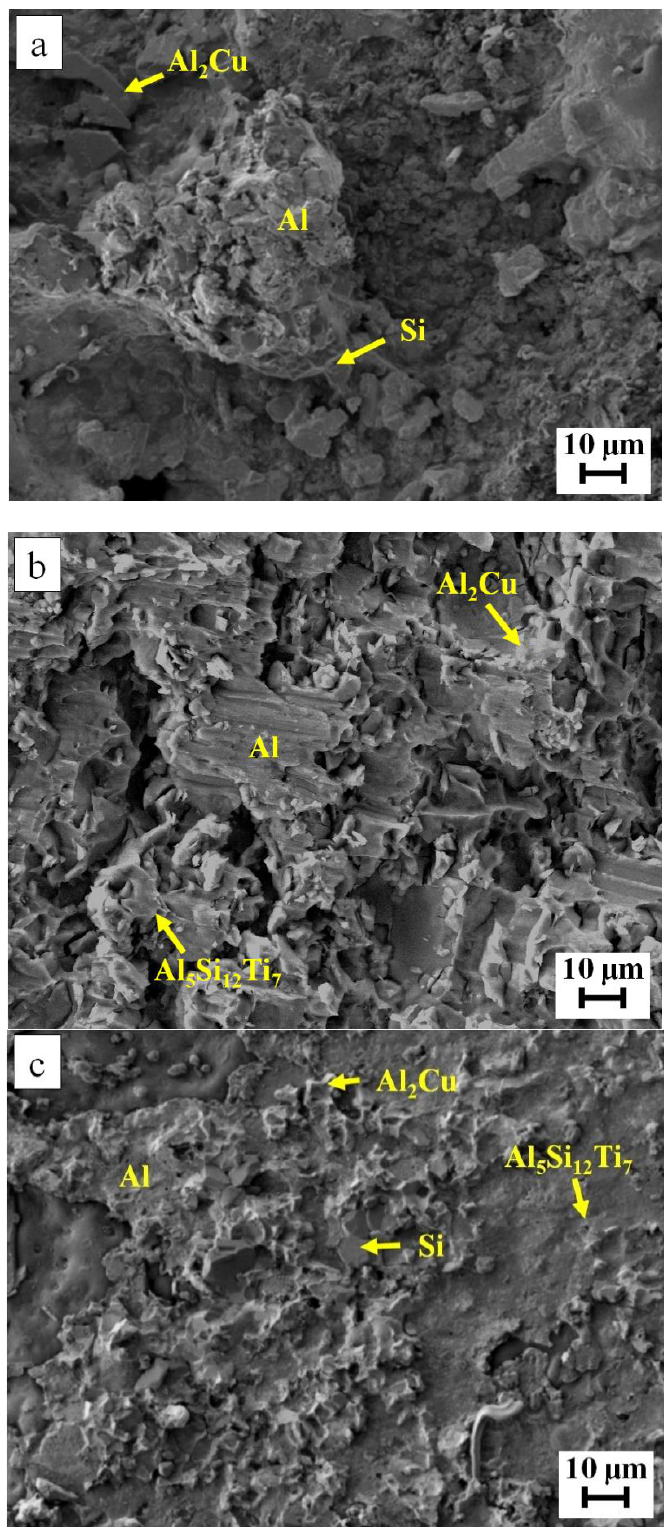
Figure 8. Fractography of the AA6061/AA6061 joints brazed with ( a ) Al10.8Si10Cu, ( b ) Al10Si10Cu4Ti and ( c ) Al10Si10Cu4Ti0.1RE filler alloys. Cross-sectional SEM micrographs under BSE mode of the AA6061/alumina joints brazed with Al10.8Si10Cu, Al10Si10Cu4Ti and Al10Si10Cu4Ti0.1RE filler alloys at 530 °C